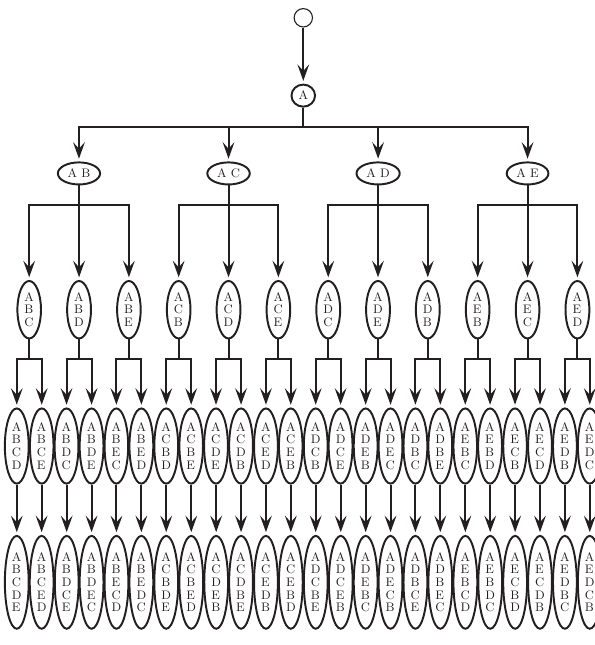
Figure 9. Fractional vertex elimination orders of Figure